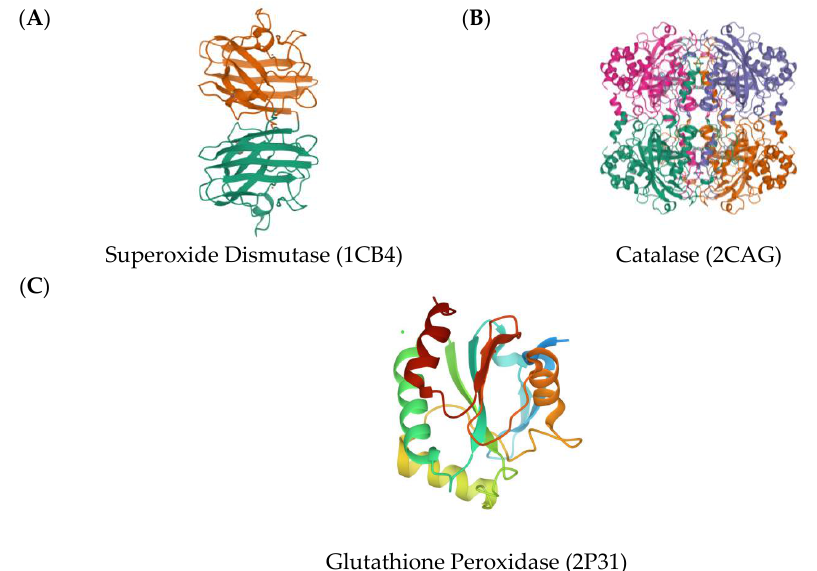
used as the target proteins to simulate the antioxidant activity of the phytochemicals (Figure 2).